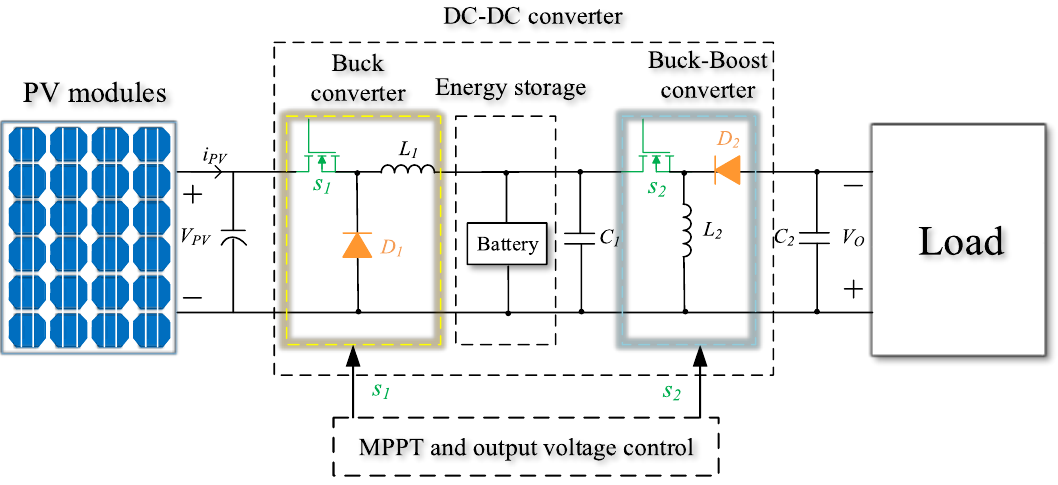
Figure 4. PV energy harvesting system with a two-stage DC-DC converter and energy